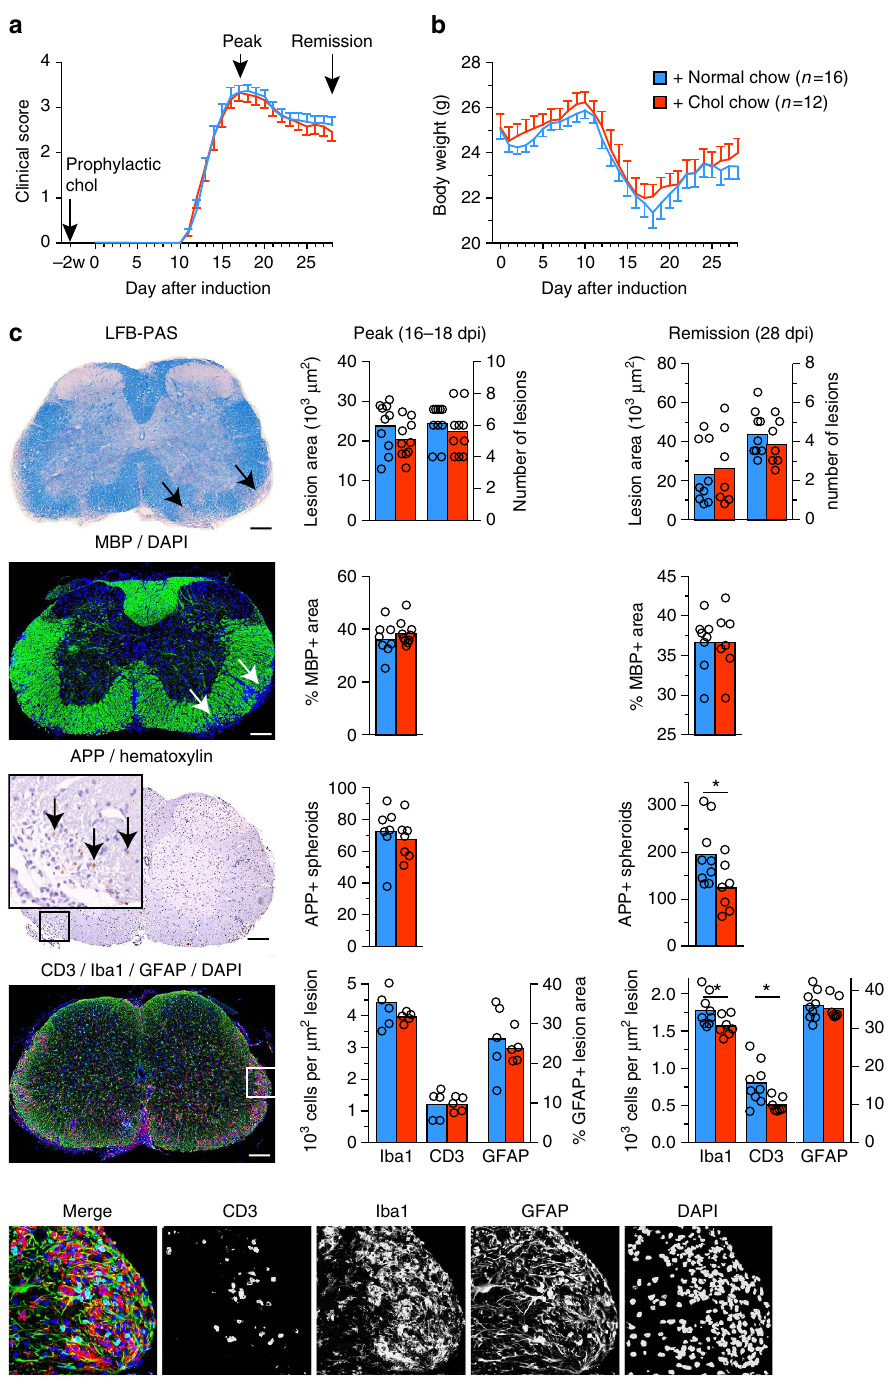
Figure 1 | Dietary cholesterol does not aggravate EAE pathology. ( a ) Clinical score of mice with MOG-EAE on normal chow or chow supplemented with 5% cholesterol ( n ¼ 12–16 mice, 2 independent experiments). Start of cholesterol feeding was prophylactic, two weeks before immunization. Arrows illustrate the time points of analyses at the peak of clinical symptoms (16–18dpi) and at remission (28dpi). ( b ) Body weight of experimental animals as in ( a ) assessed from the day of induction of EAE to the end of monitoring clinical scores (28 days). Data is expressed as mean weight ± s.e.m. of n ¼ 12–16 animals. Onset of clinical symptoms was paralleled by a drop in body weight, and mice gained weight only after the peak of disease. ( c ) Lesion characteristics were determined on sections of lumbar spinal cord from mice fed normal chow or cholesterol enriched chow ( n ¼ 5 animals, representative images on the left, scales 200 m m). Luxol fast blue-periodic acid-Schiff-hematoxylin (LFB/PAS) staining was used to determine the lesion area and number of lesions per section (arrow). Immuno-labeling for myelin basic protein (MBP) was used to determine the per cent of myelinated area within a lesion (defined in the DAPI channel as clusters of 4 20 nuclei, marked by arrows). On sections immuno-labeled for APP, the number of axonal speroids (arrows) per square mm white matter area was counted, as a readout of axonal damage. In remission, unpaired Student’s t -test revealed significantly less axonal damage in cholesterol fed animals. Sections triple stained for microglia/macrophages, Tcells, and astrocytes (Iba1-CD3-GFAP triple immuno-labeling) were used to assess the cellular composition of lesions. Unpaired t -tests revealed significantly reduced densities of microglia/macrophages and T cells in cholesterol fed animals (*, P o 0.05). Bars represent mean values with individual data